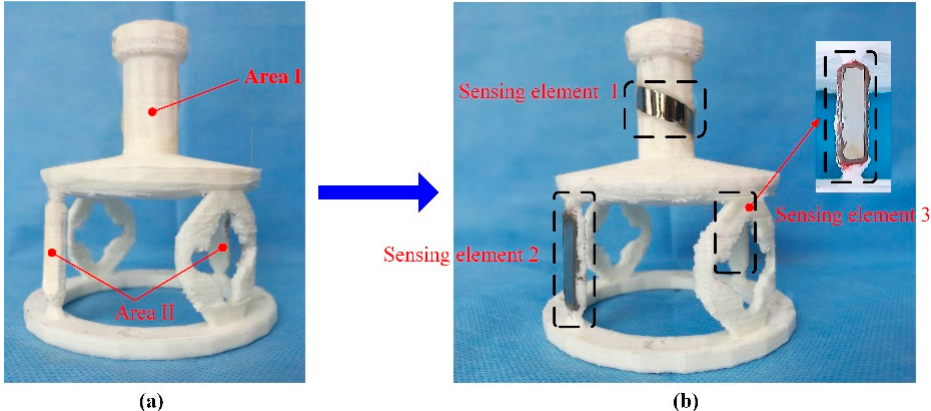
Figure 11. The 3D entity model structures of the designed sensor: ( a ) the elastomer structure model and ( b ) the pasted positions of the three